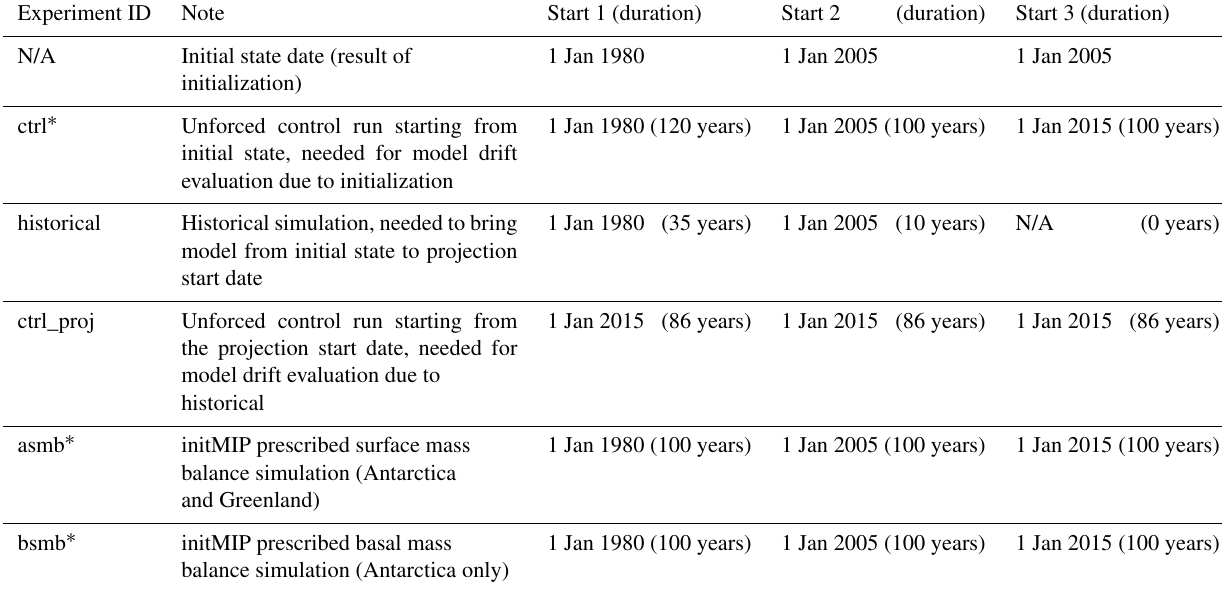
Table 4. Initialization experiments and examples of duration of experiment for different choices for initial state and projection start state. Modeling groups are free to choose initial state dates that are not indicated in this table, but the projection start state should always correspond to January